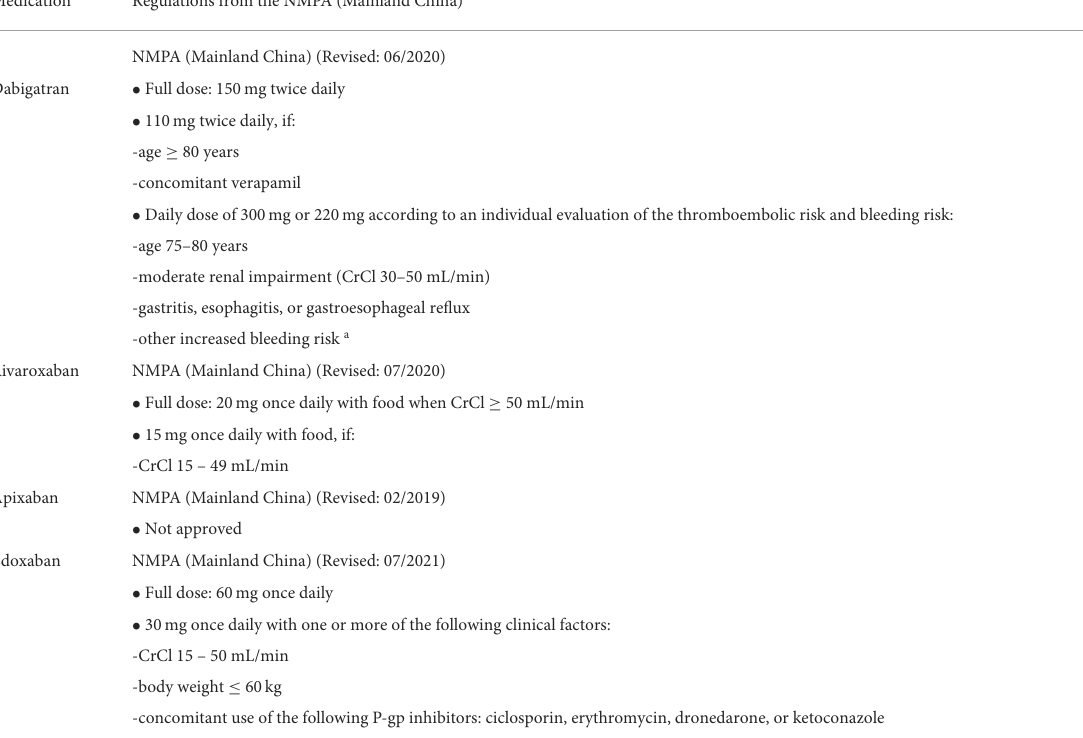
TABLE 3 Approved dosing regimens for the NOACs package inserts for NVAF in the Mainland China.